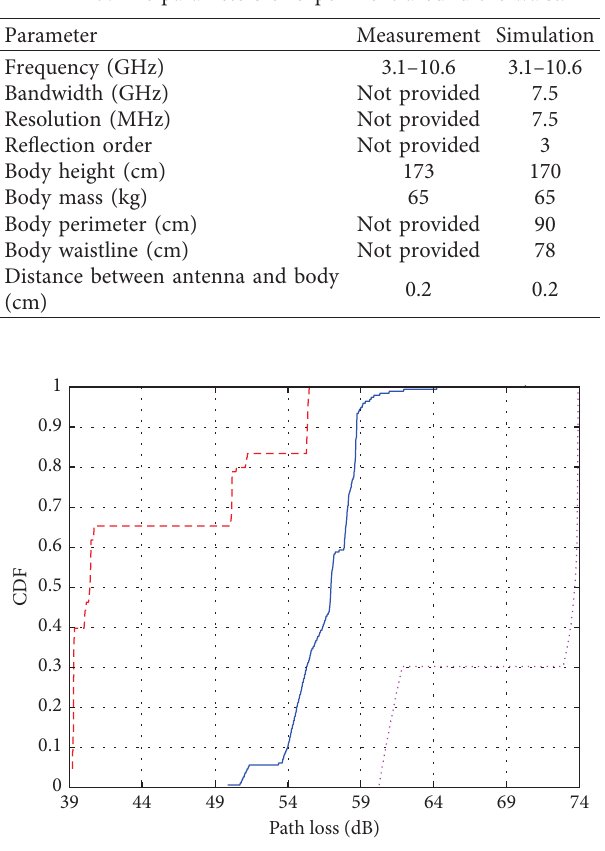
Table 7: The parameters of experiment around the